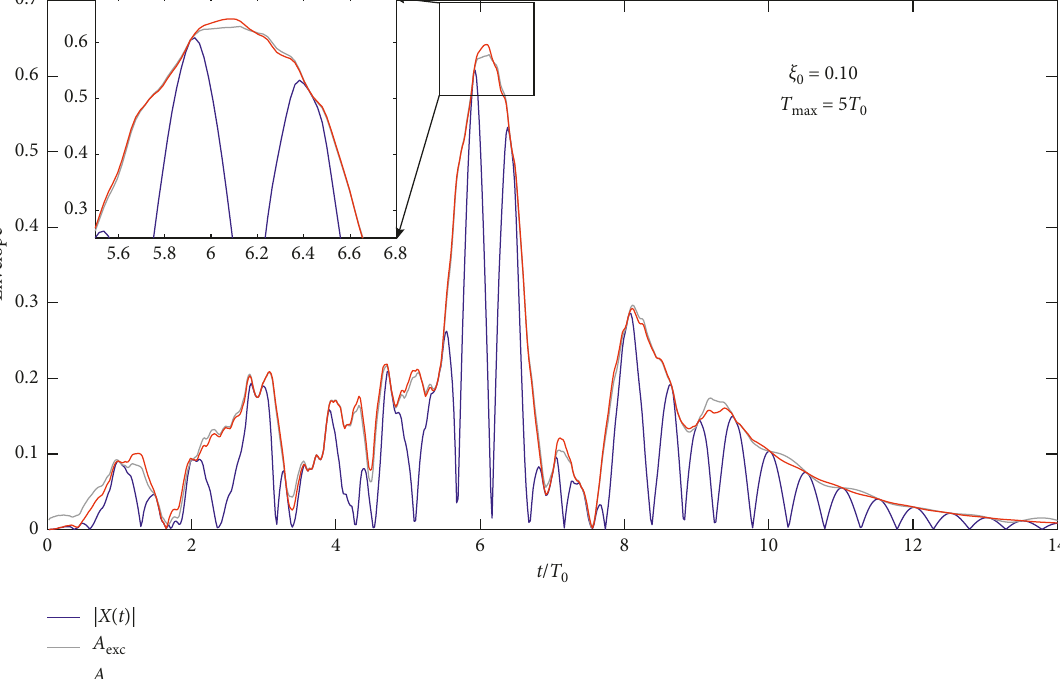
t and its envelope A ( )